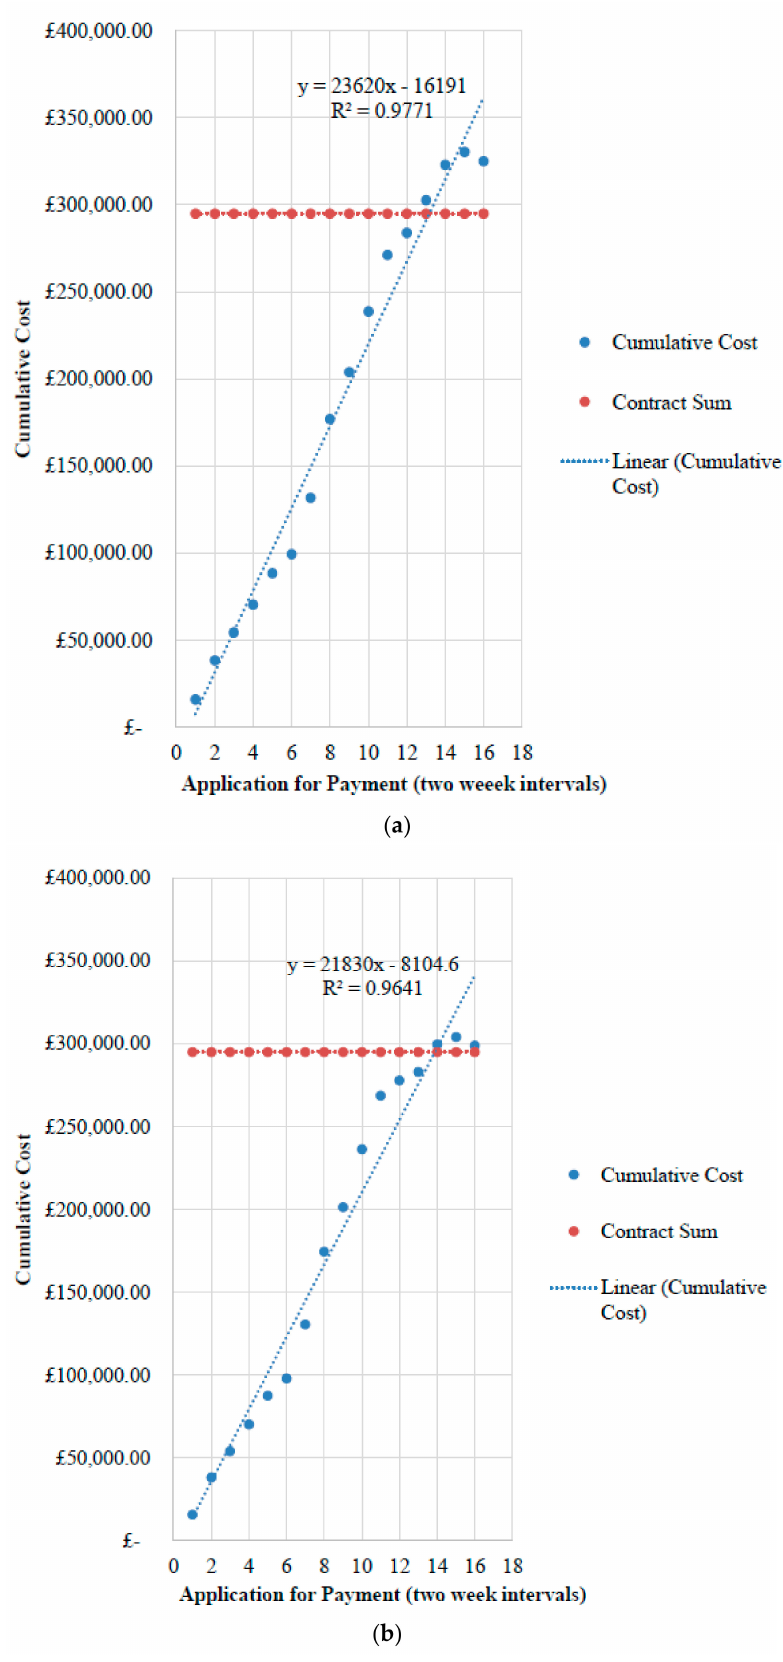
Figure 6. ( a ) Longitudinal time horizon; ( b ) longitudinal time horizon excluding additional